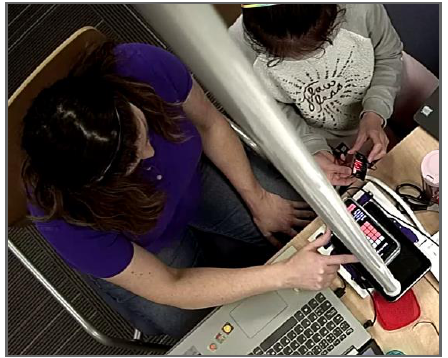
Figure 5. Camp facilitator helping troubleshoot Emily’s micro:bit.